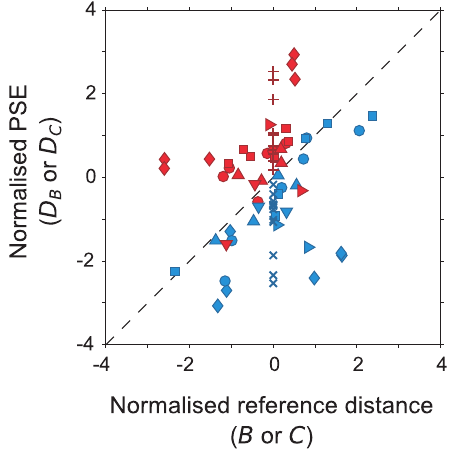
Figure 5. Normalised values of PSE for square D plotted against normalised values of the reference distance. Zero on the abscissa ( x 0 ) is the vergence angle at the ‘ideal’ reference distance, i.e. the PSE B A or C A . The difference between this ‘ideal’ value and the vergence angles of the reference squares (presented at distances B ref1 , B ref2 , C ref1 or C ref2 ) was divided by the standard deviation of the psychometric function that gave rise to PSE B A or C A ( s x ), so that, in effect, the reference distances are plotted as z-scores ( x =( x 1 2 x 0 )/ s x , where x 1 is the vergence angle of the reference surface and x is the value plotted; see Procedures S2 for details). Similarly, zero on the ordinate is the expected PSE for D if the reference was at the ‘ideal’ distance (the mean of PSE D B and PSE D C , expressed as a vergence angle, y 0 ). The difference between this ‘ideal’ PSE and the actual PSEs measured ( D B1 , D B2 , D C1 and D C2 , expressed as a vergence angles, y 1 ) were divided by the root mean square standard deviation of the psychometric functions ( s y ) that gave rise to PSE ( y =( y 1 2 y 0 )/ s y ; see Procedures S2 for details). As in Figure 4, red symbols show data for route A – B – D and blue symbols for the route A – C – D. Different symbols shapes are used for different participants. The red plusses and blue crosses re-plot the interpolated data from Figure 4 on these relative axes. They are shown at a reference vergence angle of zero, by definition in this plot, since the notional reference is always the ‘ideal’ reference distance (PSE B A or C A